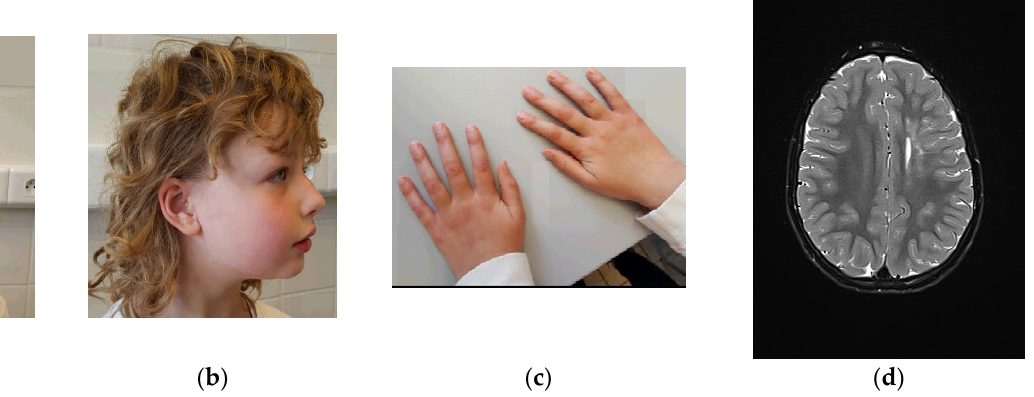
Figure 2. Physical examination at age 7 years and 4 months. ( a ) Facial features include upslanting palpebral fissures, light blue irises, epicanthal folds, fullness of the upper eyelids, a tubular nose with broad nose tip, and hypoplastic alae nares. ( b ) Side view: small auricular tag on the right ear and large ear lobes. ( c ) Picture of the hands: slender hands with rather long fingers, and slightly increased skin wrinkling. ( d ) Brain magnetic resonance imaging (MRI) at age 6 years and 9 months shows an increased T2 signal in the corona radiata on the left side. Furthermore, limited ex vacuo dilatation of the left lateral ventricle and atrophy of the anterior segment of the corpus callosum are present.